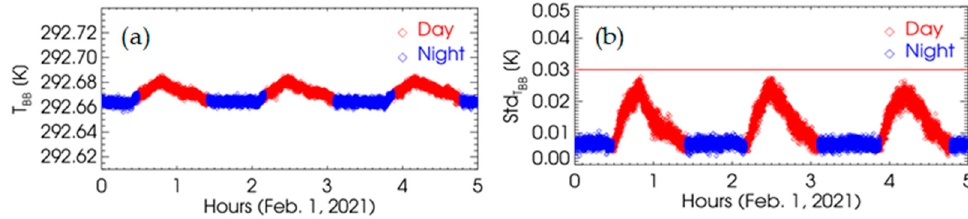
Figure 3. S-NPP VIIRS ( a ) average BB temperature and ( b ) BB uniformity for three orbits on 1 February 2021. Horizontal red line represents the BB uniformity requirement of 30 mK. Values are on a per scan basis.